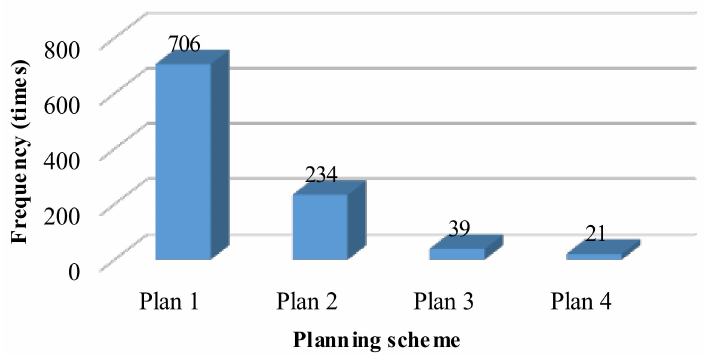
Figure 7. Frequencies of four planning schemes considering load uncertainties.